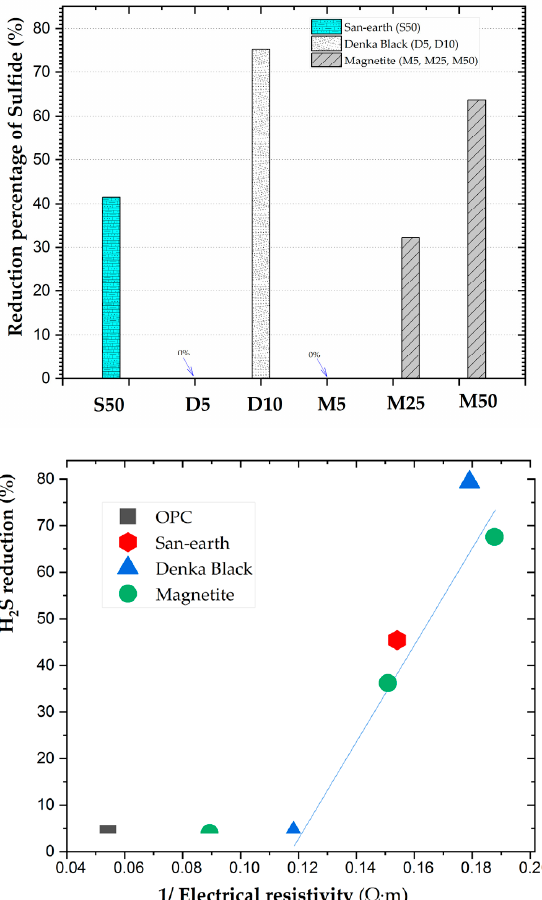
Figure 9. Percentage of the sulfide reduction obtained for the different conductive concretes; relationship between the concrete conductivity and the sulfide reduction.